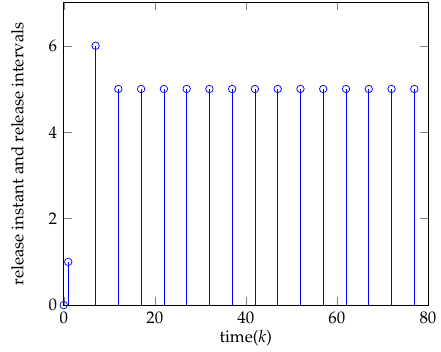
Figure 2. The event trigger release instants and intervals. The system trajectory is shown in Figure 3 and the trajectory of x T ( k ) E T REx ( k ) is shown in Figure 4, which indicate that the DC motor model is finite-time bounded and also satisfies H ∞ performance.